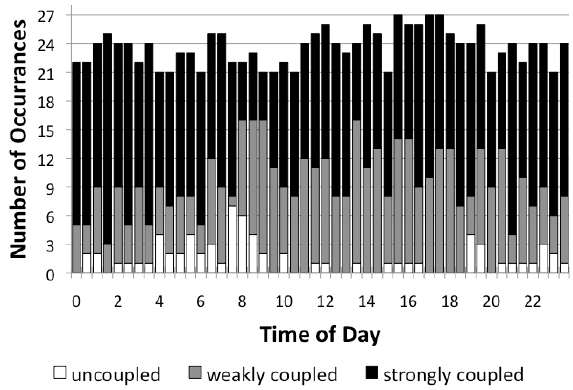
Figure 9. Number of occurrences of strongly coupled, weakly coupled, or uncoupled 843 Fig. 9. Number of occurrences of strongly coupled, weakly cou- atmosphere-­‐canopy over the time period of the campaign (time period as in Figure 4). 844 pled, or uncoupled atmosphere-canopy over the time period of the campaign (time period as in Fig.